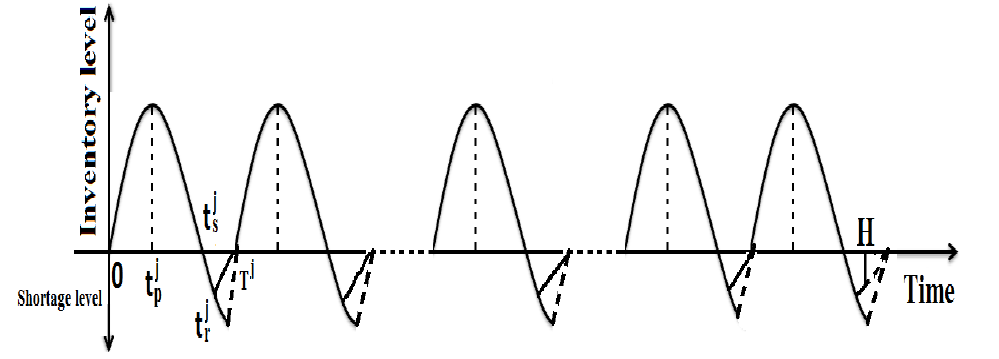
Figure 5. Graphical representation of the inventory model for